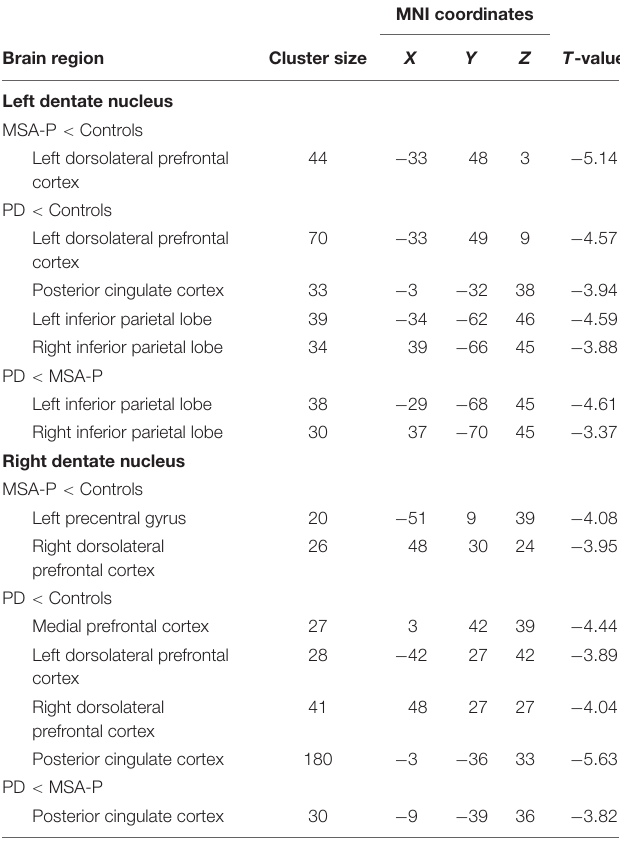
TABLE 3 | Regions showing significant differences in DN FC among MSA-P, PD, and control